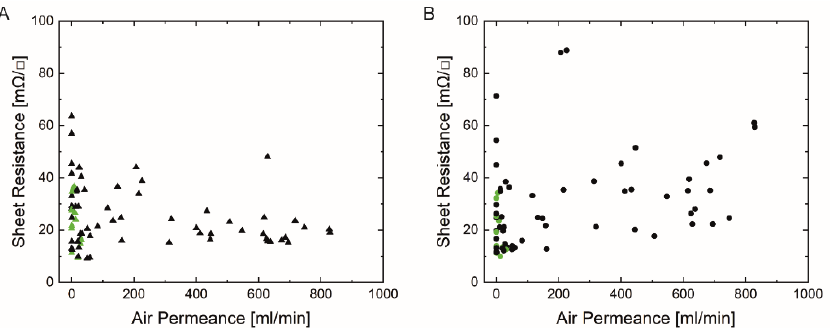
Figure 6. Sheet Resistance as function of Air Permeance of ‘Orgacon SI-P2000 ′ ( ▲ , A ) and ‘Loctite ECI 1011 ′ square prints ( ● , B ). Green symbols indicate the 13 paper samples that were selected for ECI 1011’ square prints ( • , B ). Green symbols indicate the 13 paper samples that were selected for further investigation. further